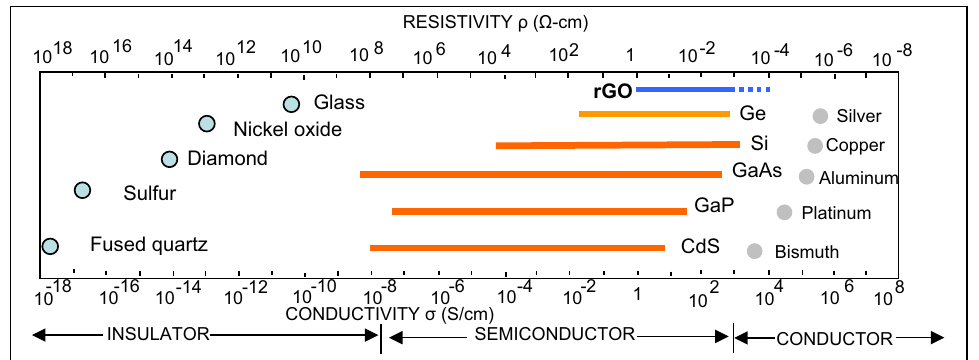
Figure 2. The rGO electrical properties compared with the main material used in the electro-optical